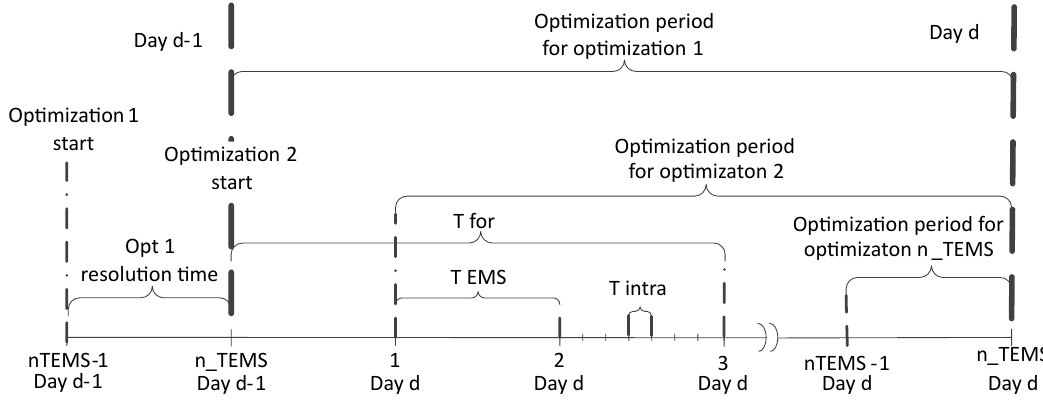
Figure 3. Temporal description of the daily execution